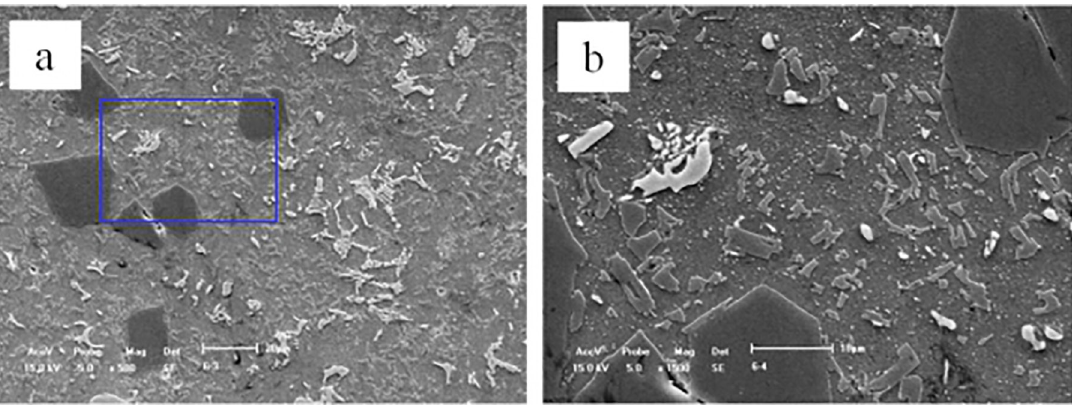
Figure 3. SEM images of A390-0.3wt%Nd alloy after extrusion at different